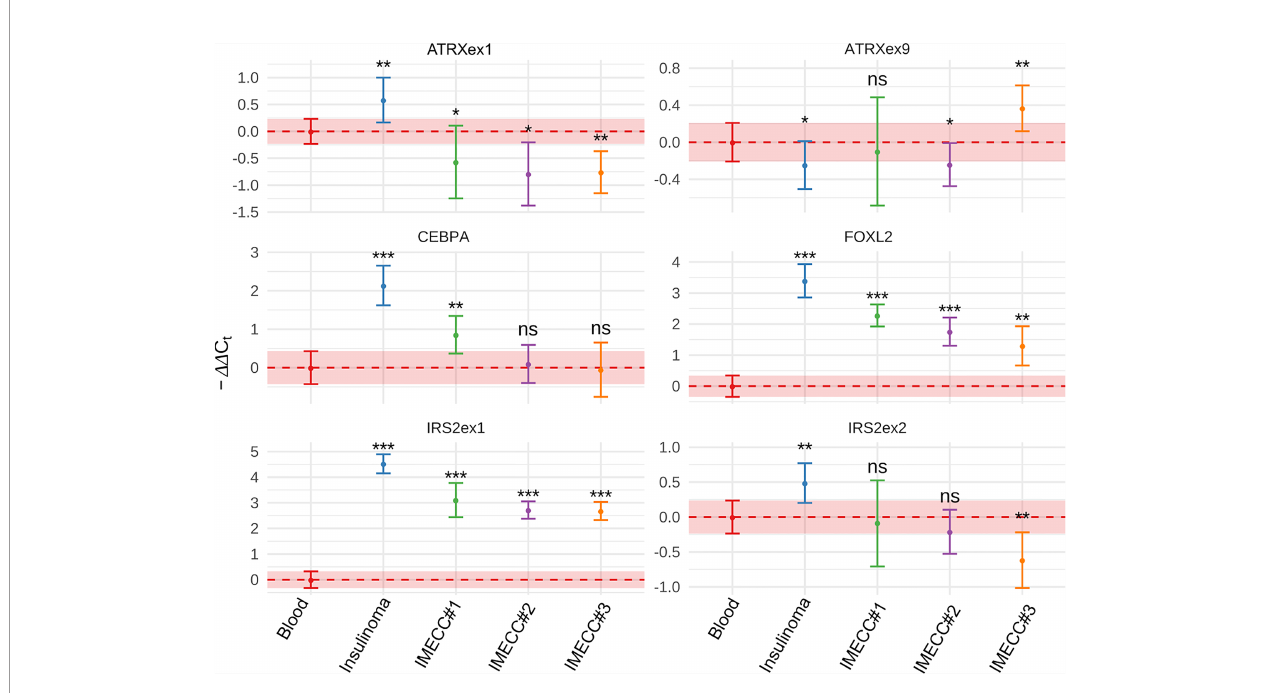
FIGURE 4 | Results of qPCR in blood, insulinoma and IMECCs by using DD Ct method. *p-value < 0.05. **p-value < 0.01. ***p-value < 0.001. ns, not signi fi